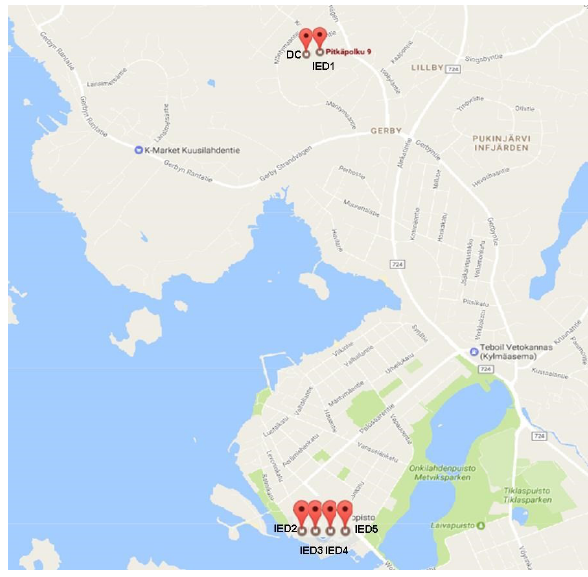
Figure 6: Communication network WAN locations